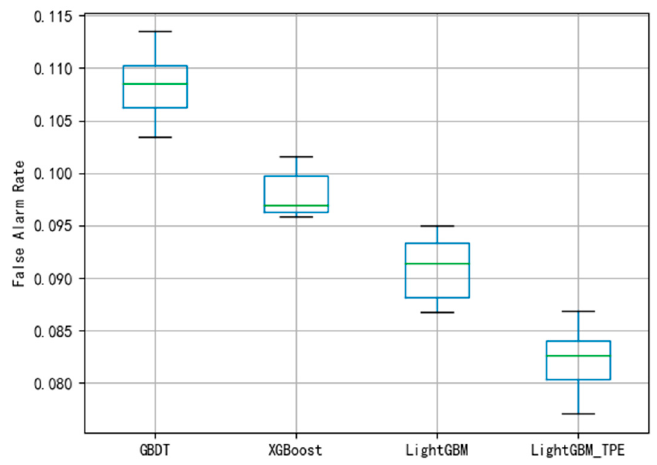
Figure 6. False alarm rates of four algorithms for fault detection of wind turbines gearboxes on dataset 1.